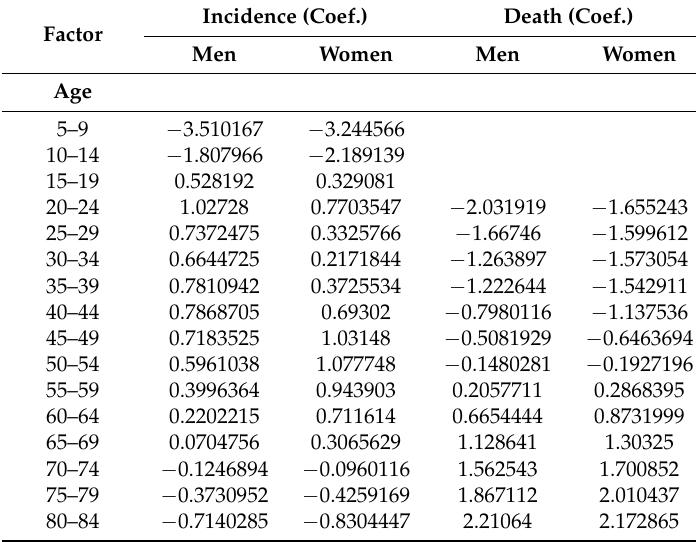
Table A1. Diabetes mellitus incidence and mortality rates estimated coefficients for the age, period and cohort effects. Incidence (Coef.) Death Factor